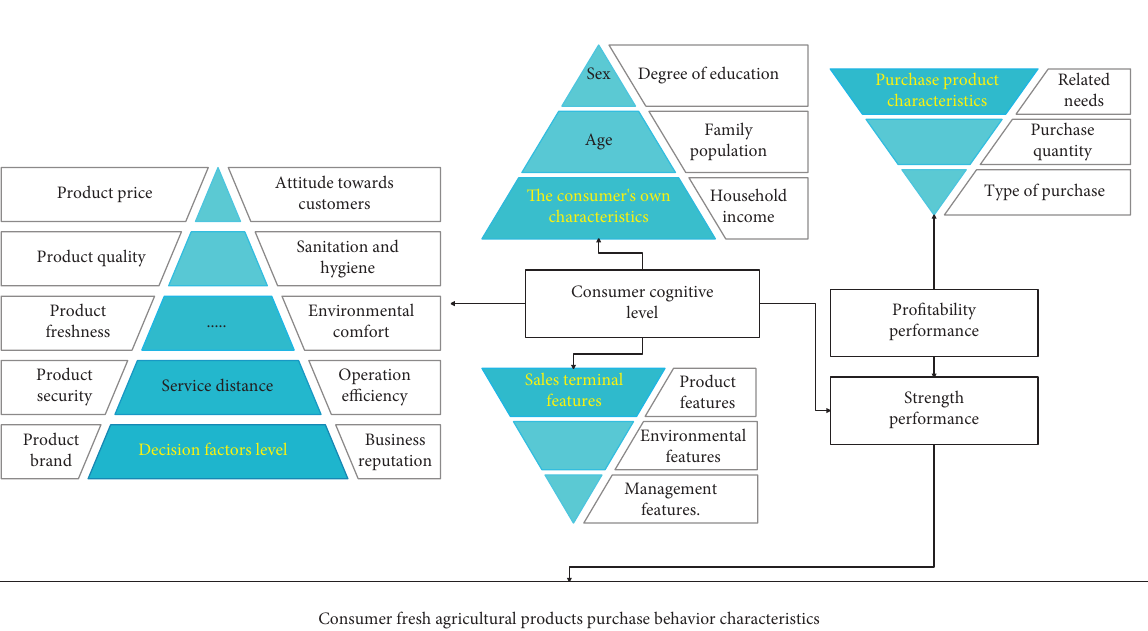
Figure 9: The comprehensive system for purchasing decision-making research on fresh agricultural products.